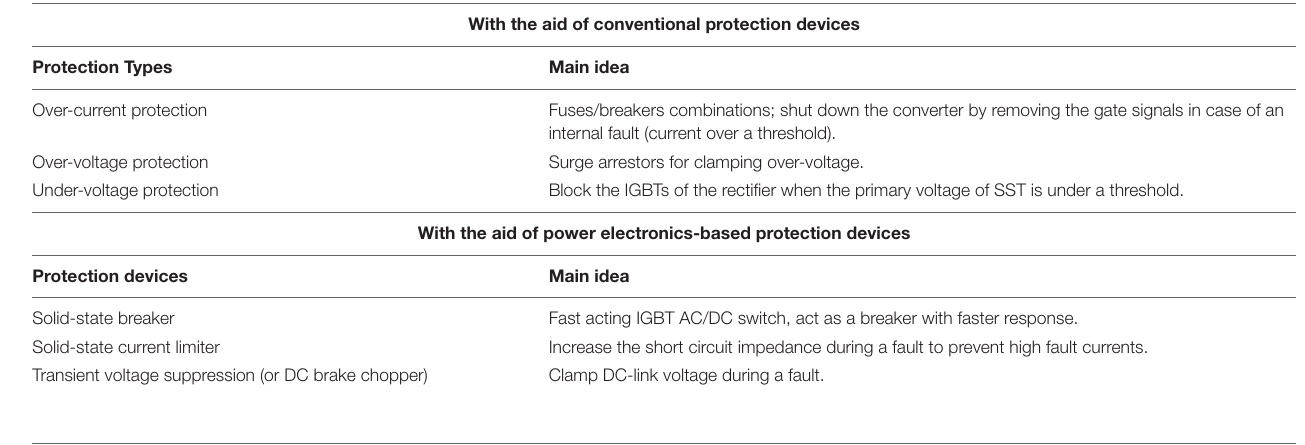
TABLE 4 | Summary of protection of solid-state